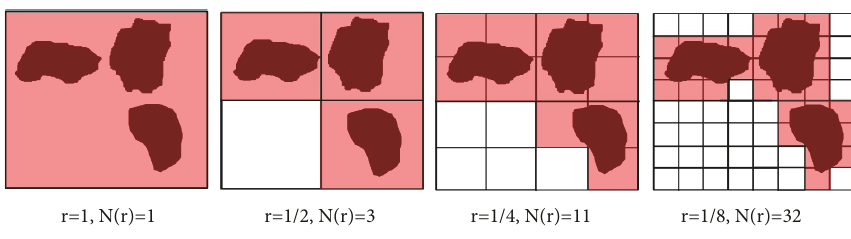
Figure 4: Illustration of an irregular object in a box-counting